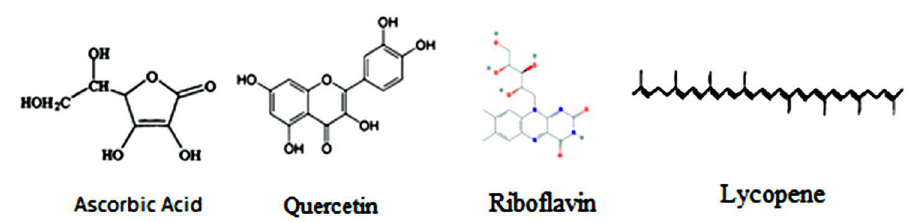
Fig. 1. Structure of compounds having most negative binding